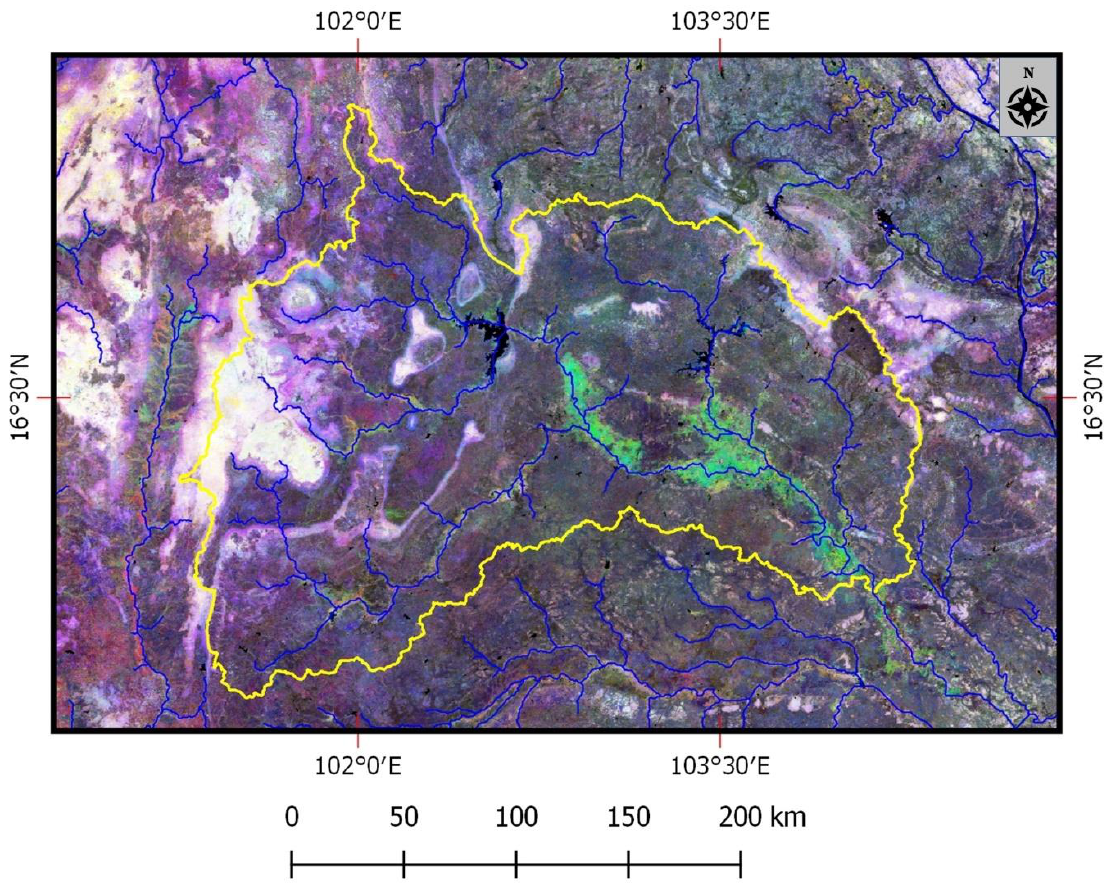
Figure 5. Example false color composite image of study area (outlined in yellow) based on 2010 monthly MODIS NDVI data in which dates 1, 3, and 5 are assigned to the RGB color guns. The RGB shows irrigated, double-cropped rice along waterways in a cyan tone. The waterways (in blue) are included to aid interpretation.